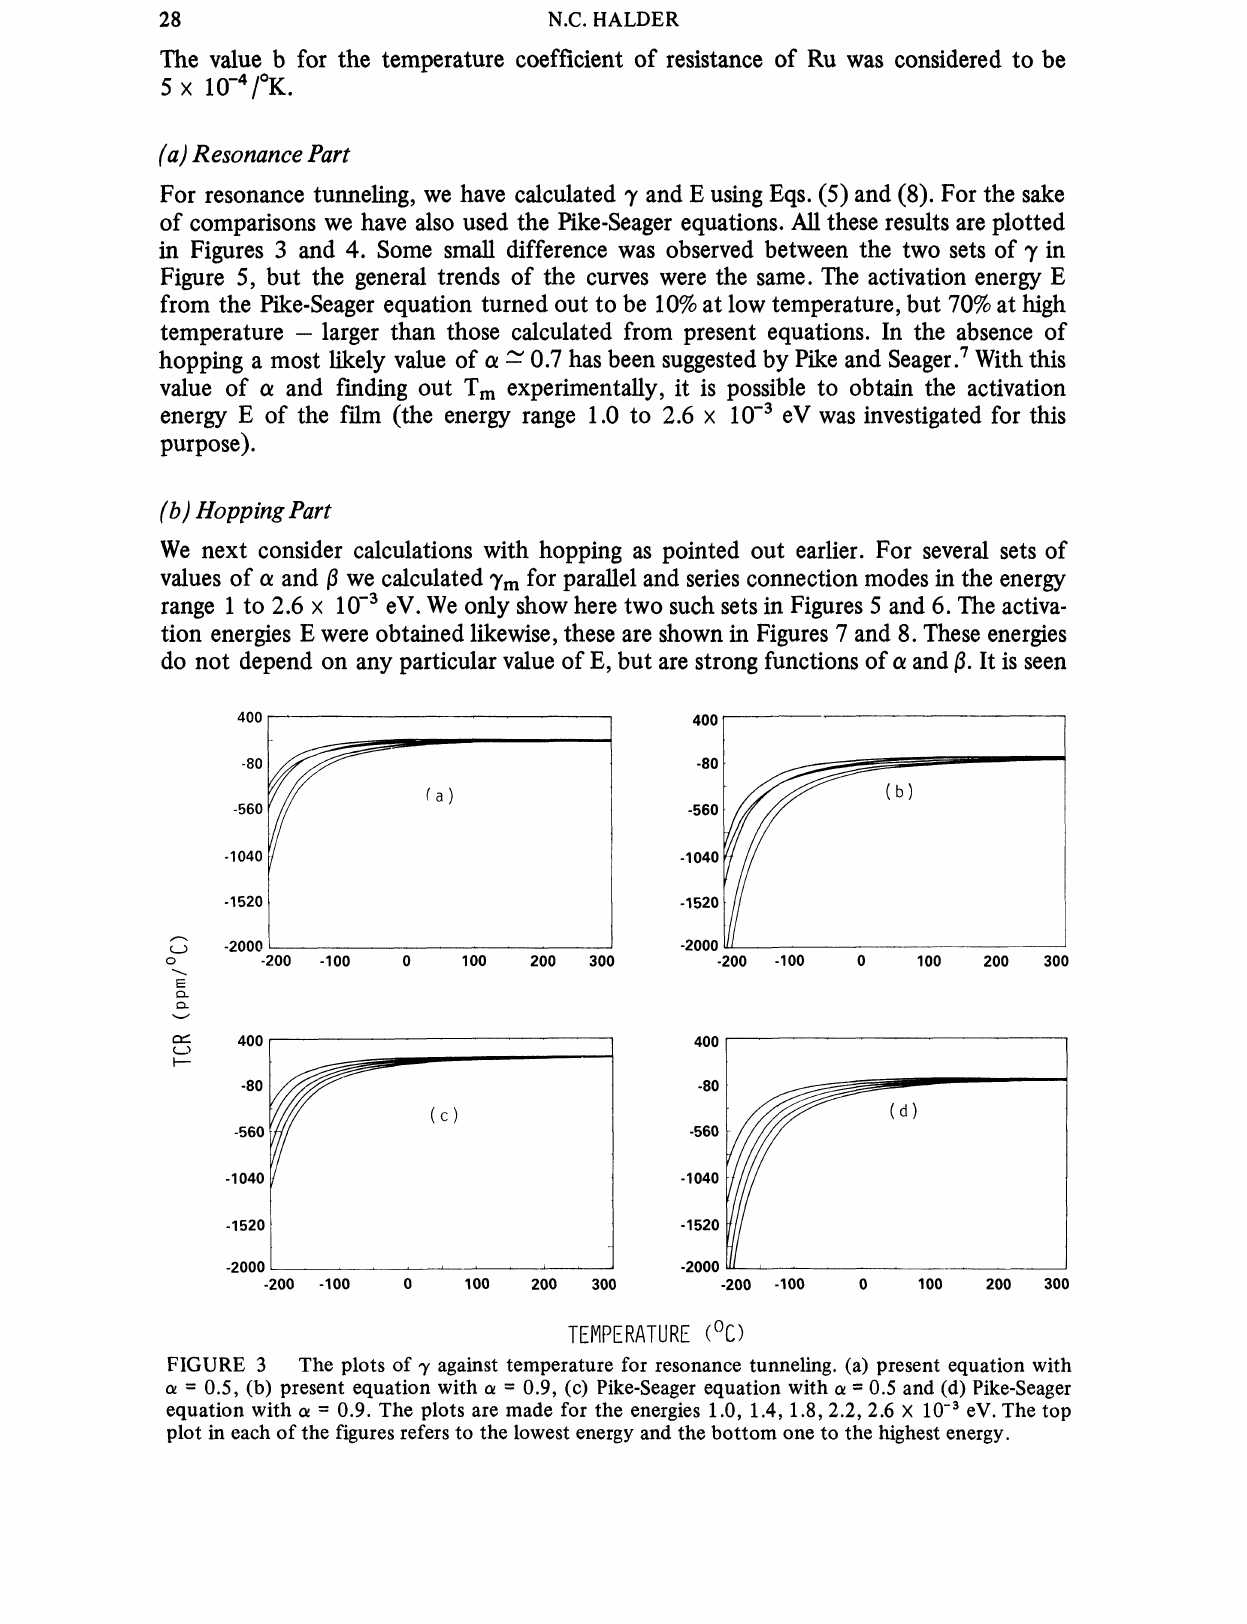
The plots of 3’ against temperature for resonance tunneling. (a) present equation with a 0.5, (b) present equation with a 0.9, (c) Pike-Seager equation with a 0.5 and (d) Pike-Seager equation with a 0.9. The plots are made for the energies 1.0, 1.4, 1.8, 2.2, 2.6 10 -3 eV. The top plot in each of the figures refers to the lowest energy and the bottom one to the highest